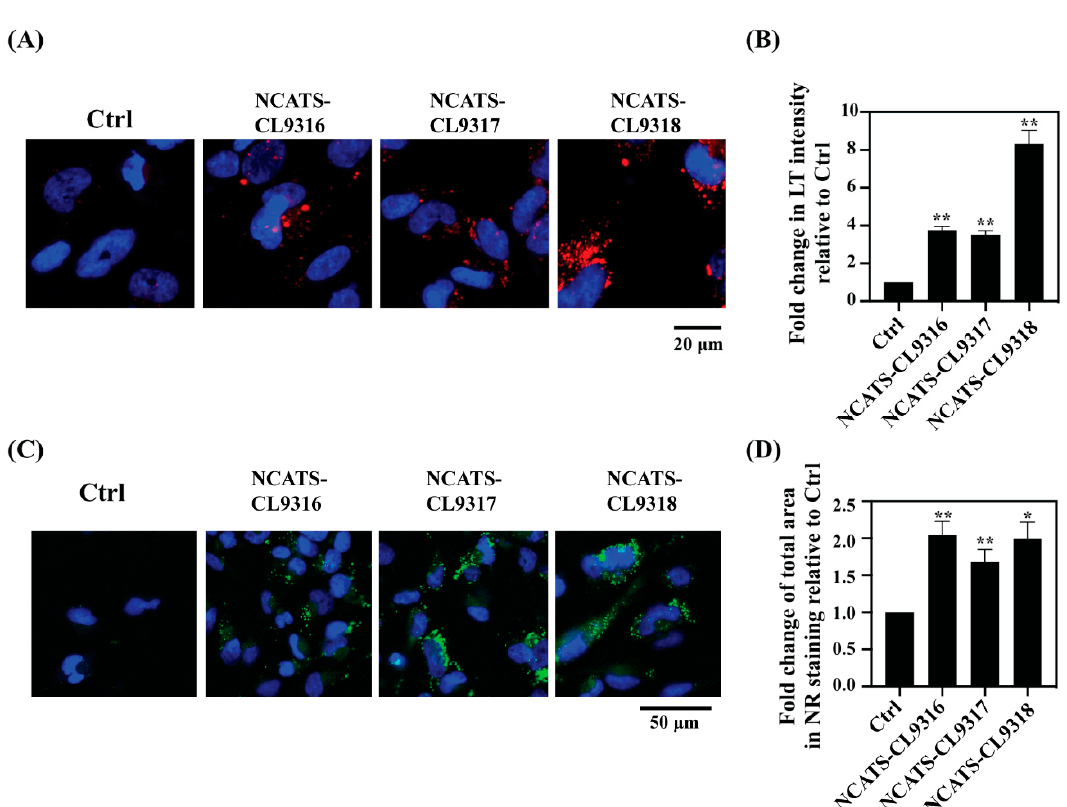
Figure 2. Pompe disease NSCs present increased lysosomal staining and lipid droplet accumulation. ( A ) Representative images for LysoTracker staining (red) in NSCs. Nuclei are stained with Hoechst (blue); merged images are shown. ( B ) Bar diagram presents the quantitation of LysoTracker intensity in disease lines relative to the control (Ctrl) cells. Error bars represent SEM of three independent experiments (** p < 0.01 by t -test). ( C ) Representative images for Nile red staining (green) of NSCs. Nuclei are stained with Hoechst (blue); merged images are shown. ( D ) Bar diagram presents the quantitation of total area of the stained puncta in disease lines relative to the control cells. Error bars represent SEM of three independent experiments (* p < 0.05 and ** p < 0.01 by t -test).